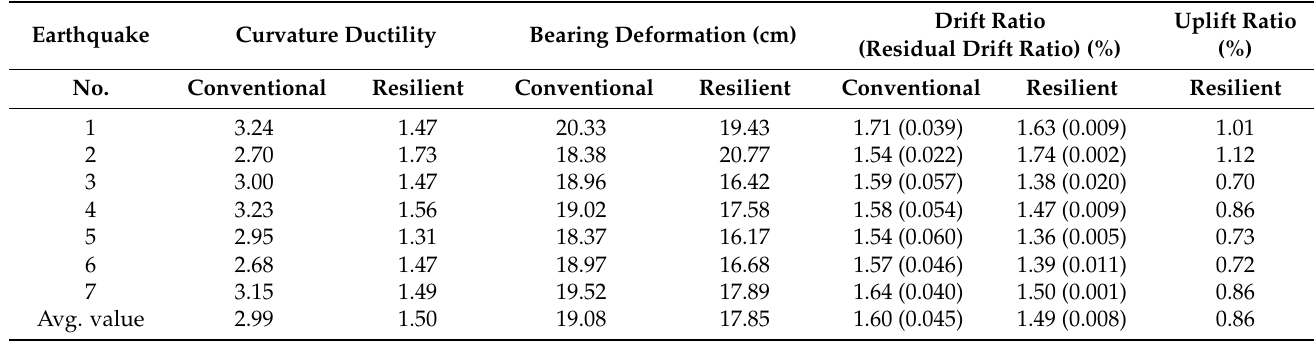
Table 2. Maximum seismic responses of RC bridges at E2